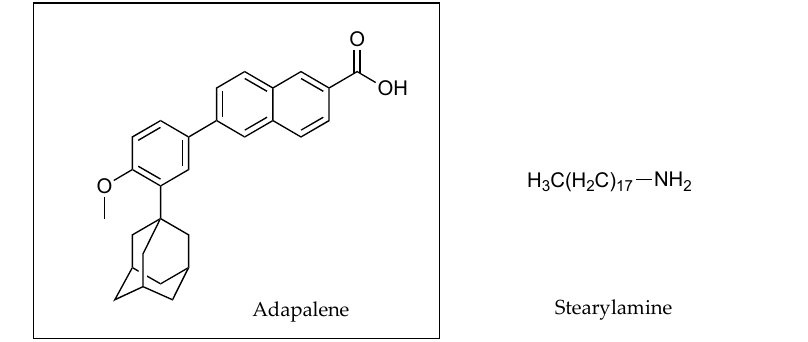
Figure 18. Adapalene and stearylamine counter ion.